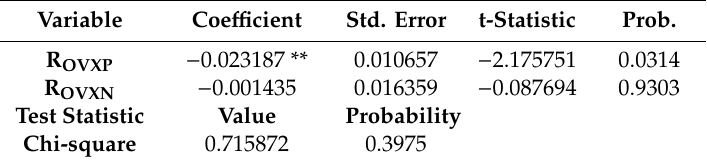
Table 24. Regression results for positive and negative oil price volatility.